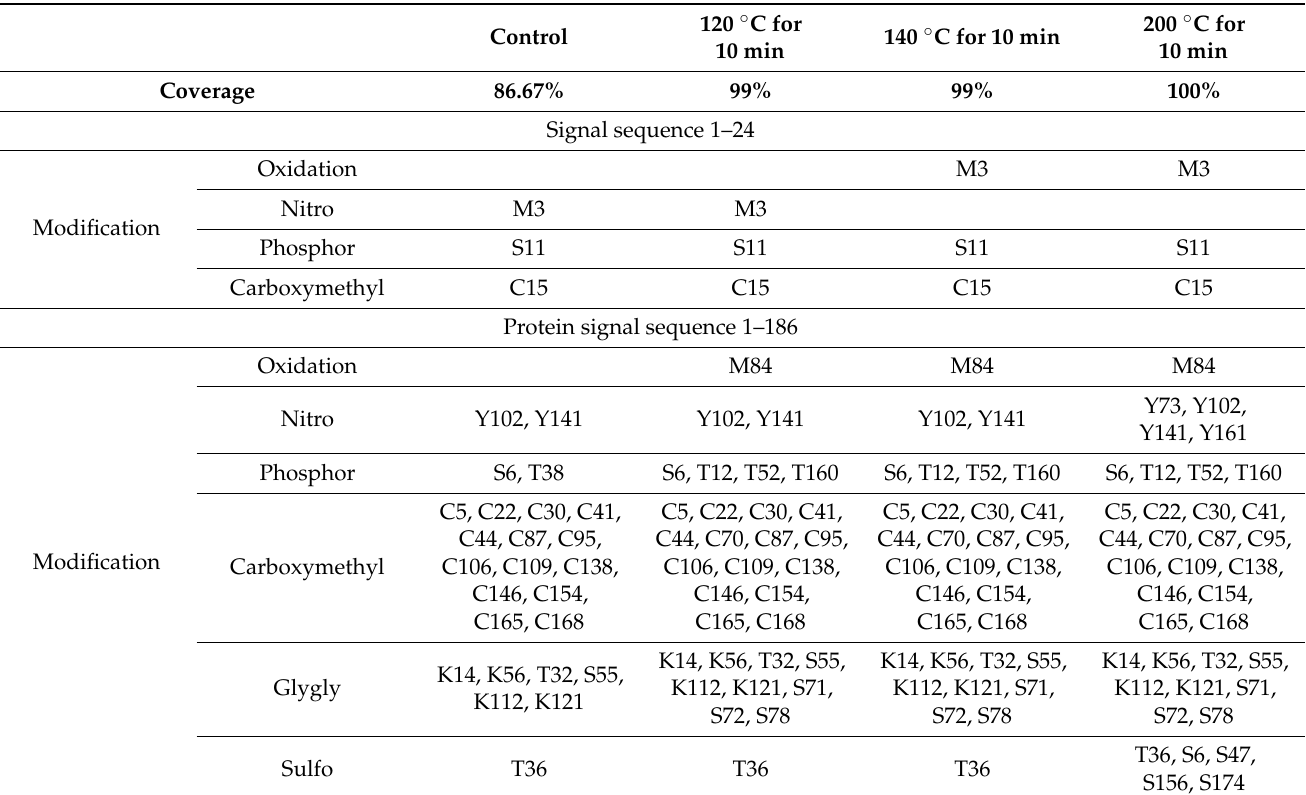
Table 1. Modified peptides and sites of the OVM treated by